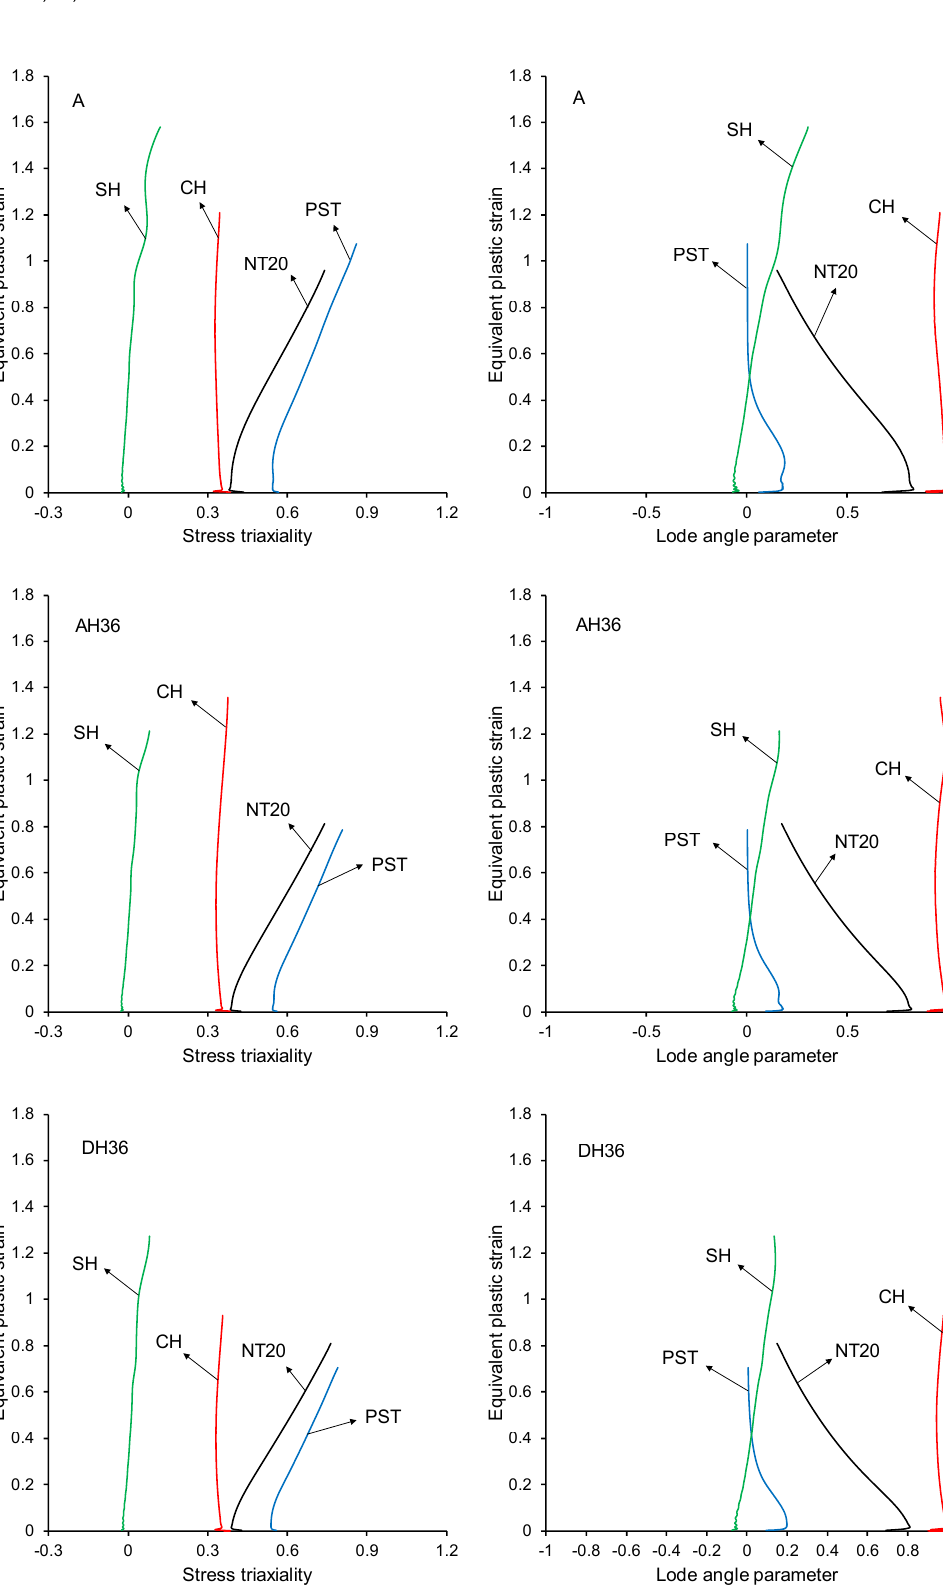
Figure 14. Loading paths to fracture